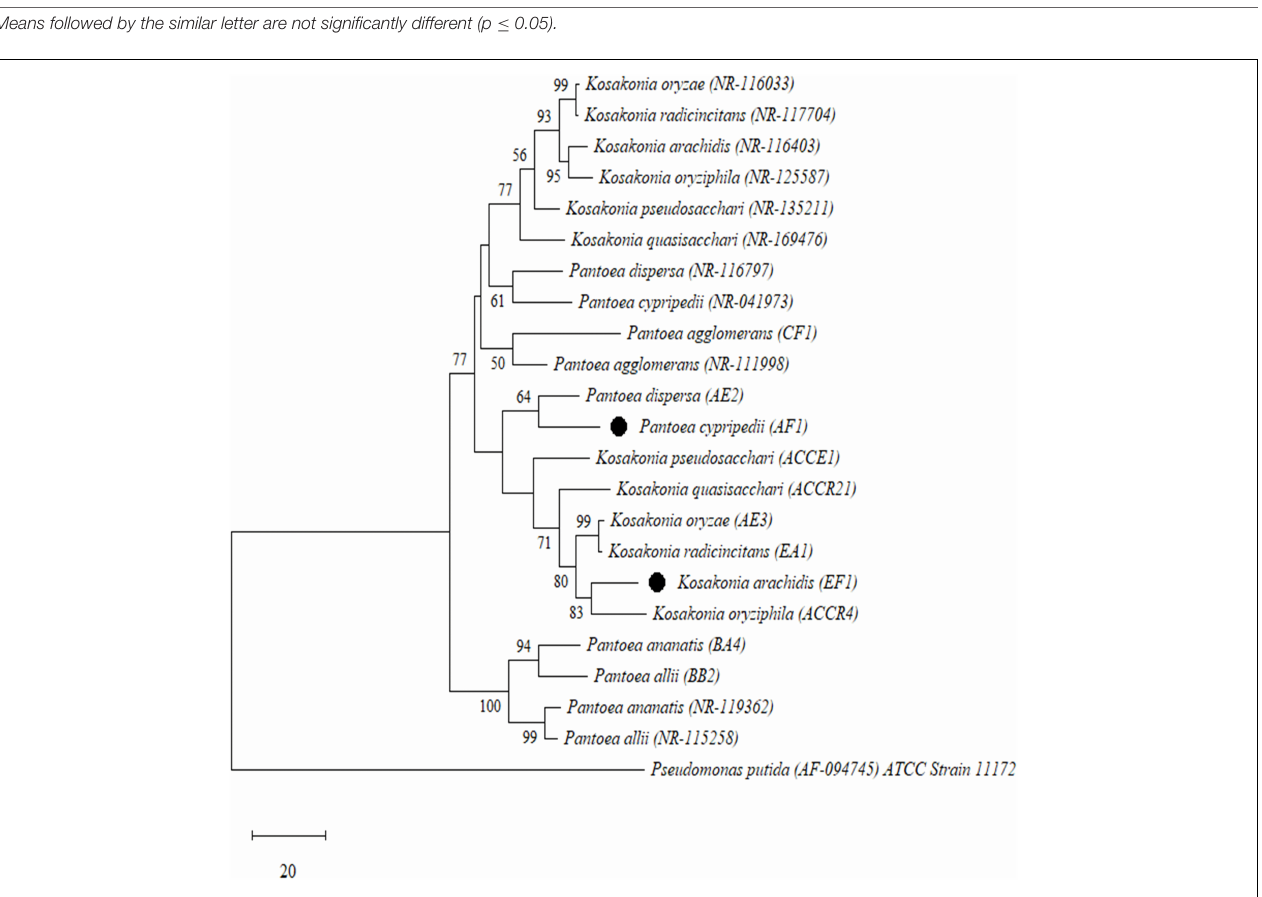
FIGURE 1 | Phylogenetic tree analysis based on the partial 16S rRNA gene sequences of all selected Gram-negative endophytic nitrogen-fixing bacterial isolates isolated from sugarcane root. Scale bar means the number of changes per base location and Pseudomonas putida was used as an outgroup.